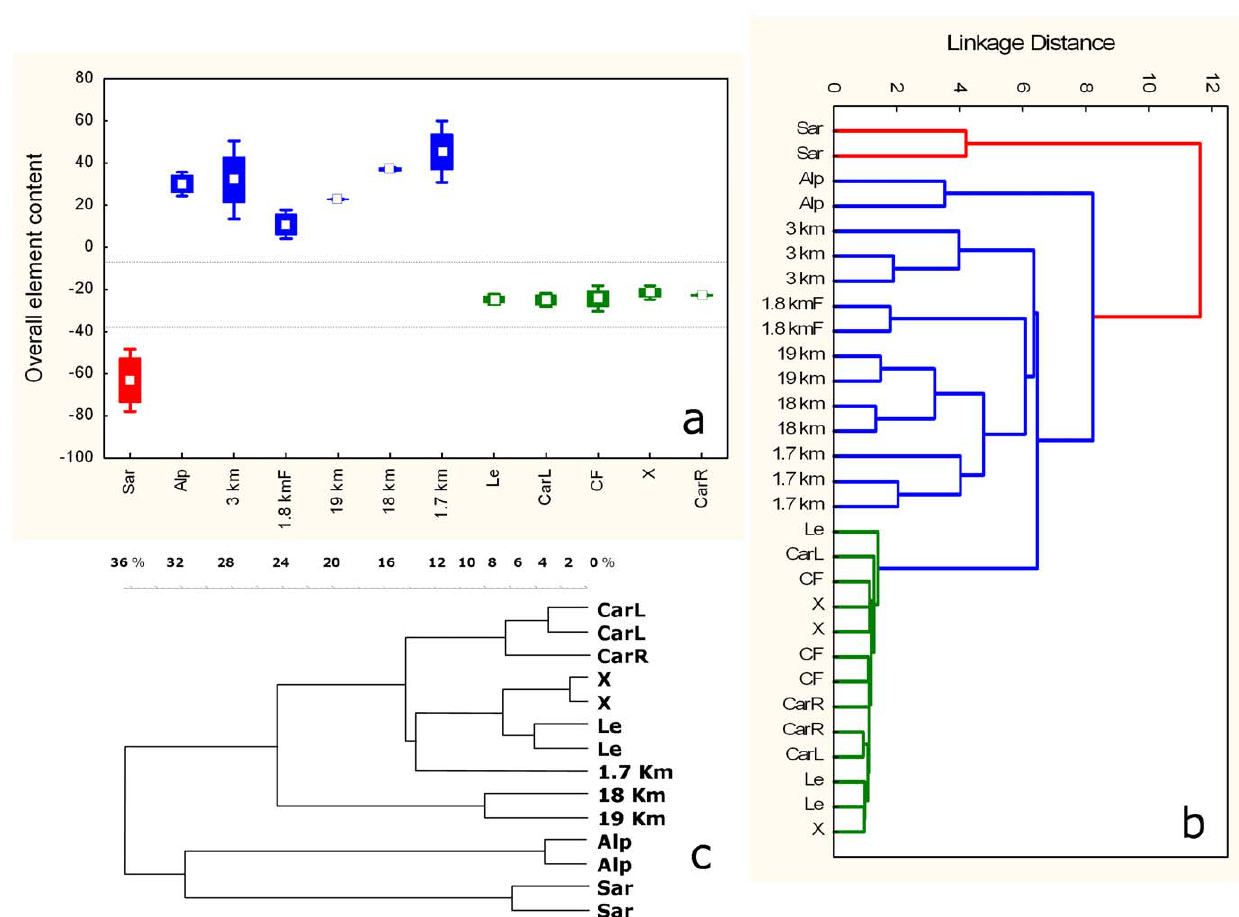
Figure 2. Results of the analyses on the soil samples compared with two specimens of soil (CarR, CarL), found respectively on the right and left carpets of the suspect’s car floor. a, b) ICP analysis of the content of 54 mineral elements. a): Box and whiskers synthetic representation of the variability of the 12 zones; b) Cluster analysis (single linkage, Euclidean distance) of the data; c) Amplified Ribosomal DNA Restriction Analysis (ARDRA) of the soil bacterial communities. The Neighbour Joining dendrogram resulting from Pearson correlation analysis of the combined three enzymes electrophoretic profiles is shown. The horizontal scale indicates the percent distance. In b) and c) sample replicates are included to show the degree of inter-replicate variability.